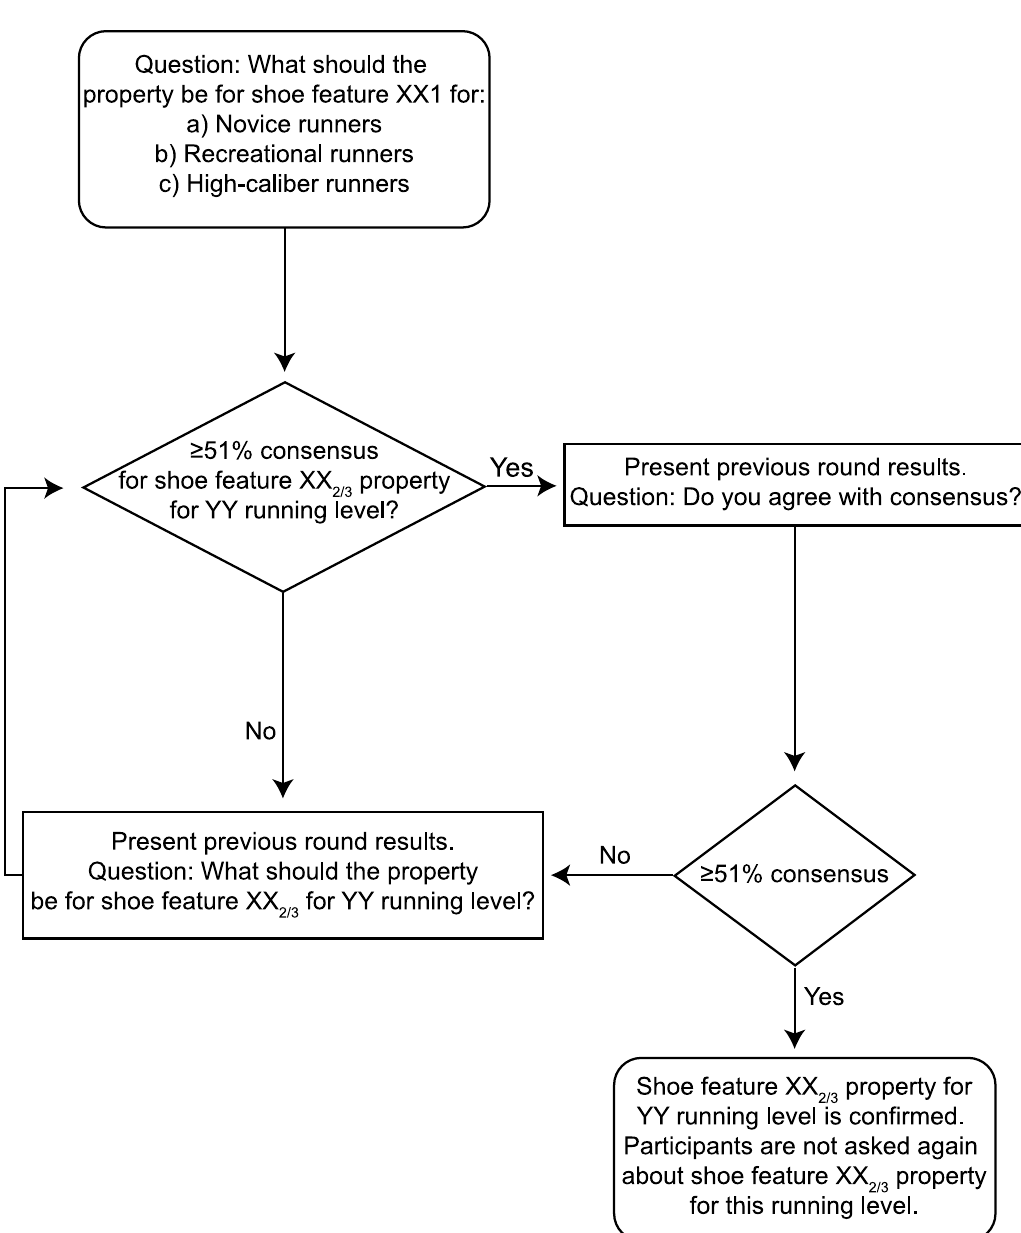
Fig 1. Flowchart describing the consensus and verifying consensus process for different shoe feature properties (XX) for each running level (YY). The participants were asked to provide feedback for the recommended properties for all runner levels on all 20 shoe features (XX 1 ). In the second- and third-rounds, the participants were asked to provide feedback for the recommended properties for all runner levels on the important shoe features and any additional shoe features the participants recommended (XX 2/3